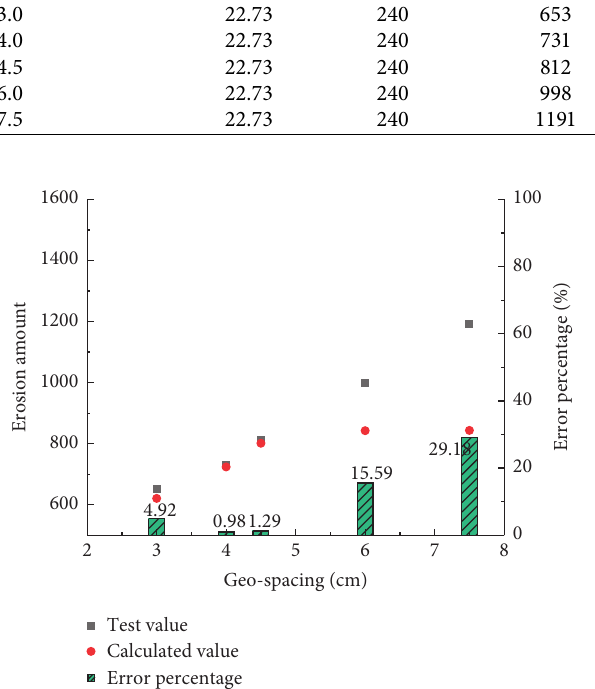
Figure 11: Comparison of calculated and measured erosion amounts of reinforced tailings.